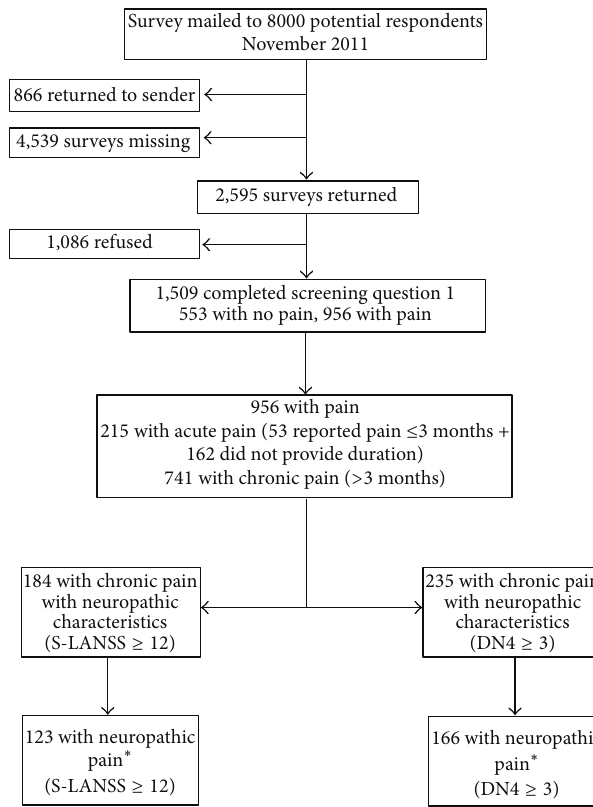
Figure 1: Flowchart of sample participants. Question 1 : Are you currently troubled by pain or discomfort, either all the time or on and off? ∗ Diagnosed with a likely or possible neuropathic pain condition and positive on the screening